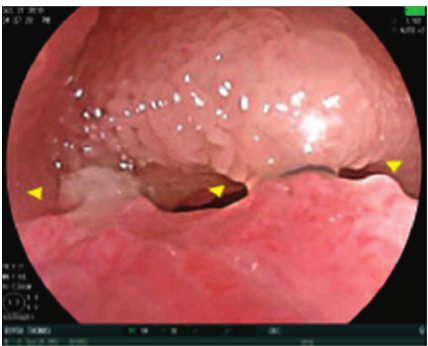
Figure 3: Ulcerated and inflamed nodular area (15mm × 20 mm) in distal ileum identified on DBE and measured at 95cm from the ileal valve. This area was subsequently biopsied and tattooed with carbon black in preparation for